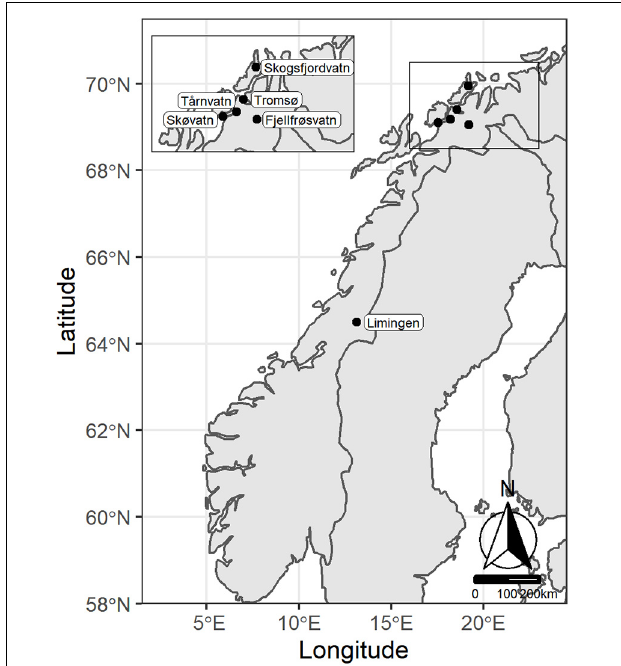
FIGURE 1 | Map of five Norwegian lakes with polymorphic Arctic charr populations used in the present study. Map prepared using the packages ggplot2 (Wickham, 2016), sf (Pebesma, 2018), ggsn (Santos Baquero, 2019), and ggspatial (Dunnington, 2021) in R (R Development Core Team, 2018) using the RStudio (RStudio Team, 2020) interface with map queried from the package rnaturalearth (South, 2017) using the ne_countries function.